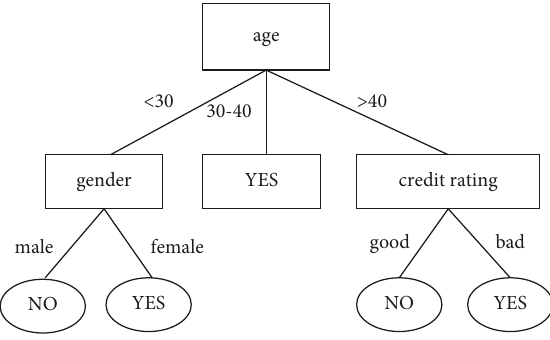
Figure 4: Schematic diagram of decision tree.